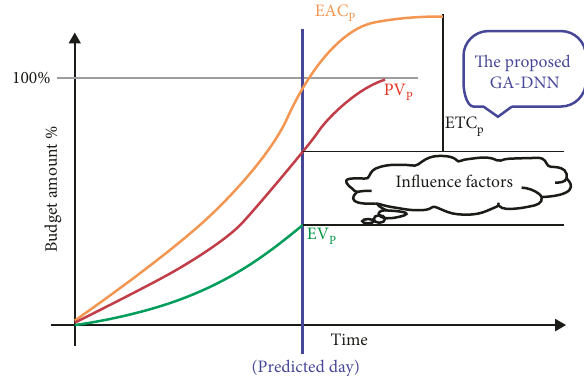
Figure 1: The proposed GA-DNN model for the prediction of the